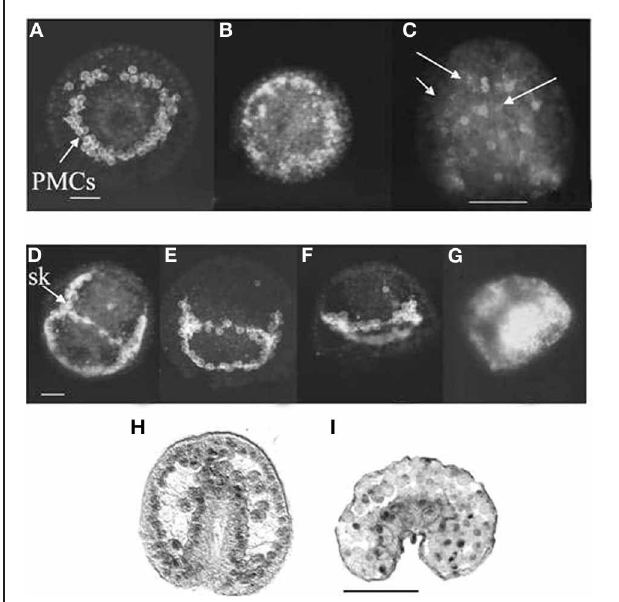
FIGURE 12 | Sea urchin gastrulae exposed to diazinon during fertilization. Arrows point to PMCs. Upper rows: WGA affinity sites for primary mesenchime cells (PMC). (B,C) 10 − 4 M diazinon; (E–G) 10 − 5 M, 10 − 4 ; 10 − 3 M diazinon. (A,D) controls (Pesando et al., 2003). (H,I) OTX2 immunoreactivity in control (H) and exposed to 10 − 5 M diazinon (I) larva (Aluigi et al., 2008). Sk, skeletal rod; bar = 10 μ m; (C,H,I) bar = 50 μ